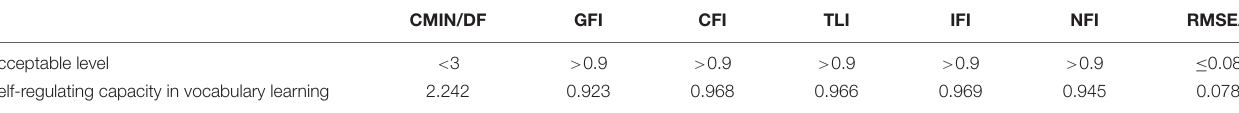
TABLE 2 | Commonly used confirmatory factor analysis (CFA) fit indices.